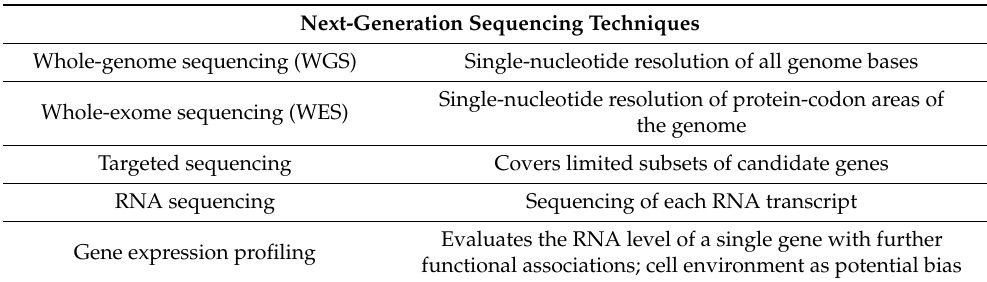
Table 3. Next-generation sequencing terms.